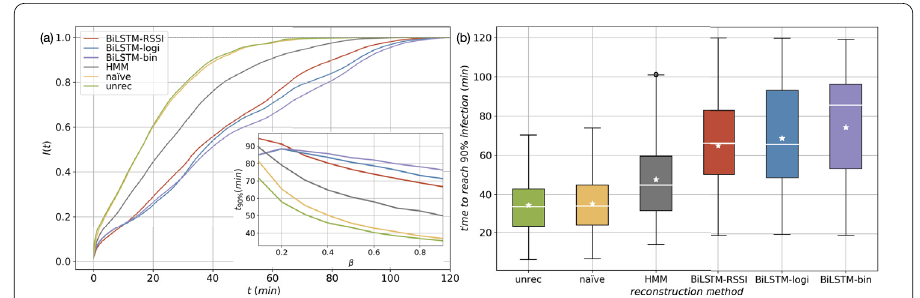
Figure 6 Characterisation of information spreading on reconstructed networks. ( a ) Average spreading curves of susceptible-infected processes with β = 1 simulated on different reconstructed temporal networks as indicated in the key. Inset shows the β dependencies of the speed of spreading processes measured as the average t 90% 90% infection time. ( b ) Distributions of 90% infection times as box-plots for the different reconstruction methods in case of β = 1. Distribution averages are represented by stars. For the parameters